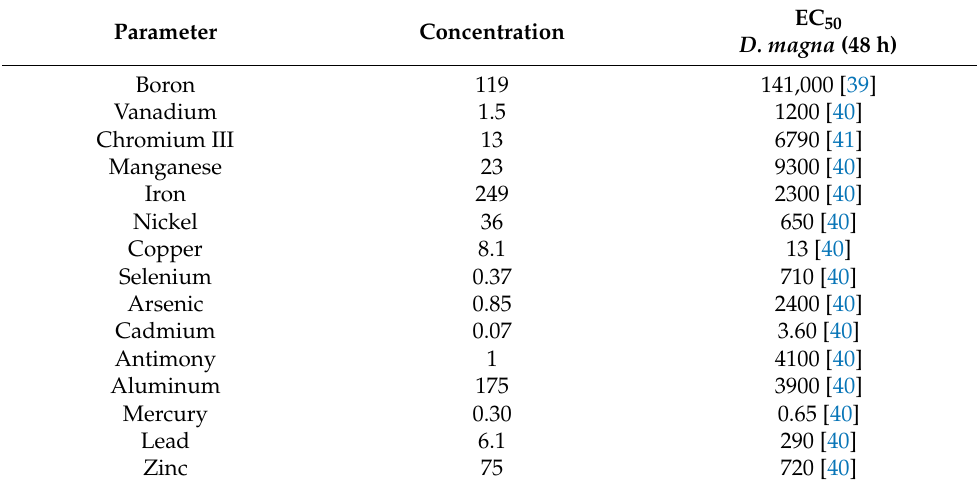
Table 4. Metals and semimetals effluent concentrations measured during the monitoring campaign (average values, in µ g/L).